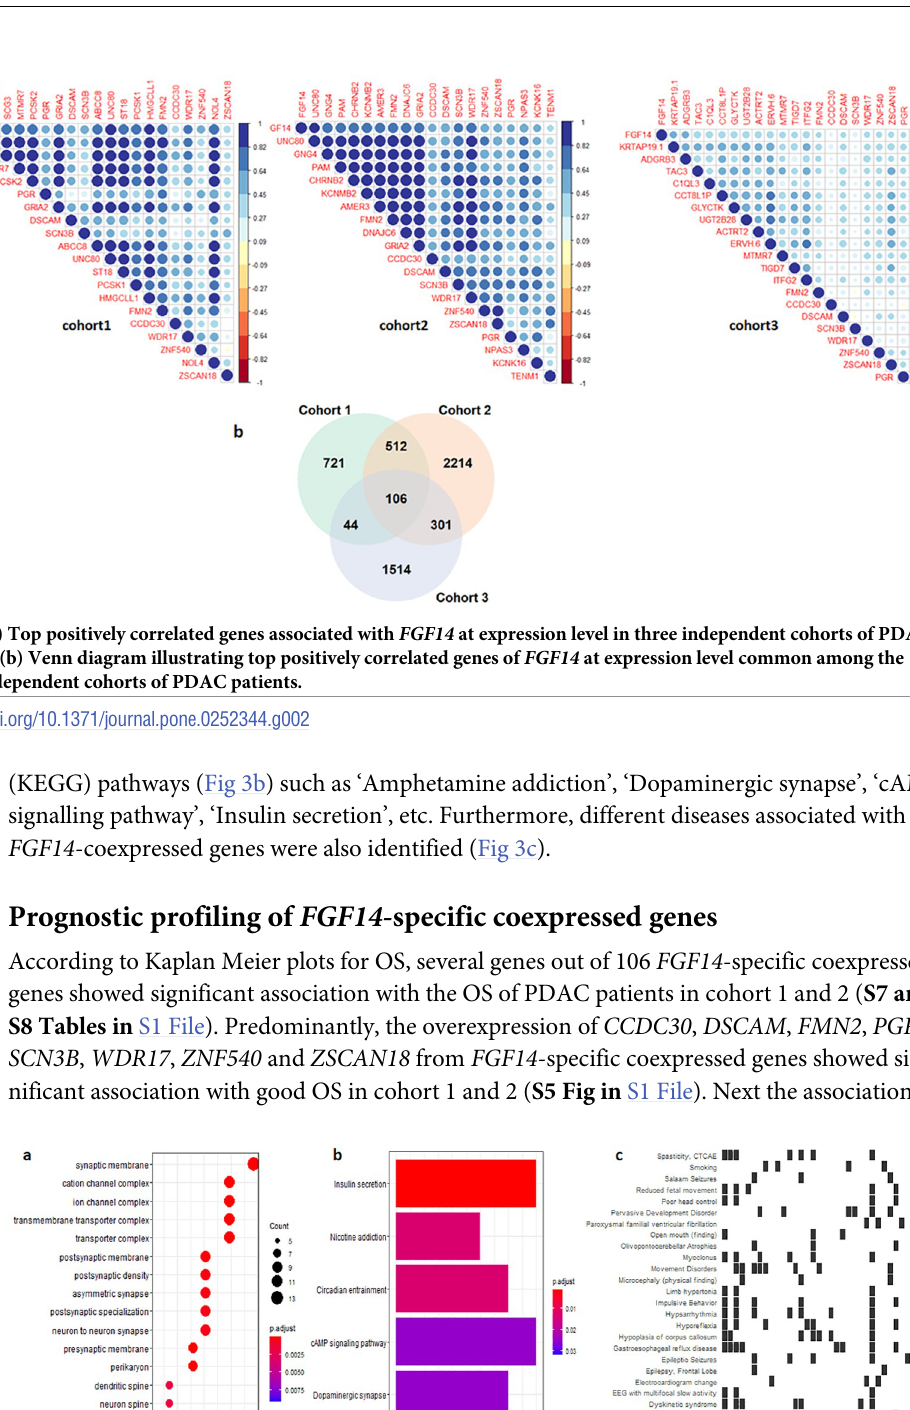
Fig 3. (a) Enriched GO terms among the FGF14 -specific coexpressed genes common in all three cohorts of PDAC patients (b) Pathway analysis of FGF14 -specific coexpressed genes common in all three cohorts of PDAC patients (c) Gene-disease associations of FGF14 -specific coexpressed genes common in all three cohorts of PDAC patients.